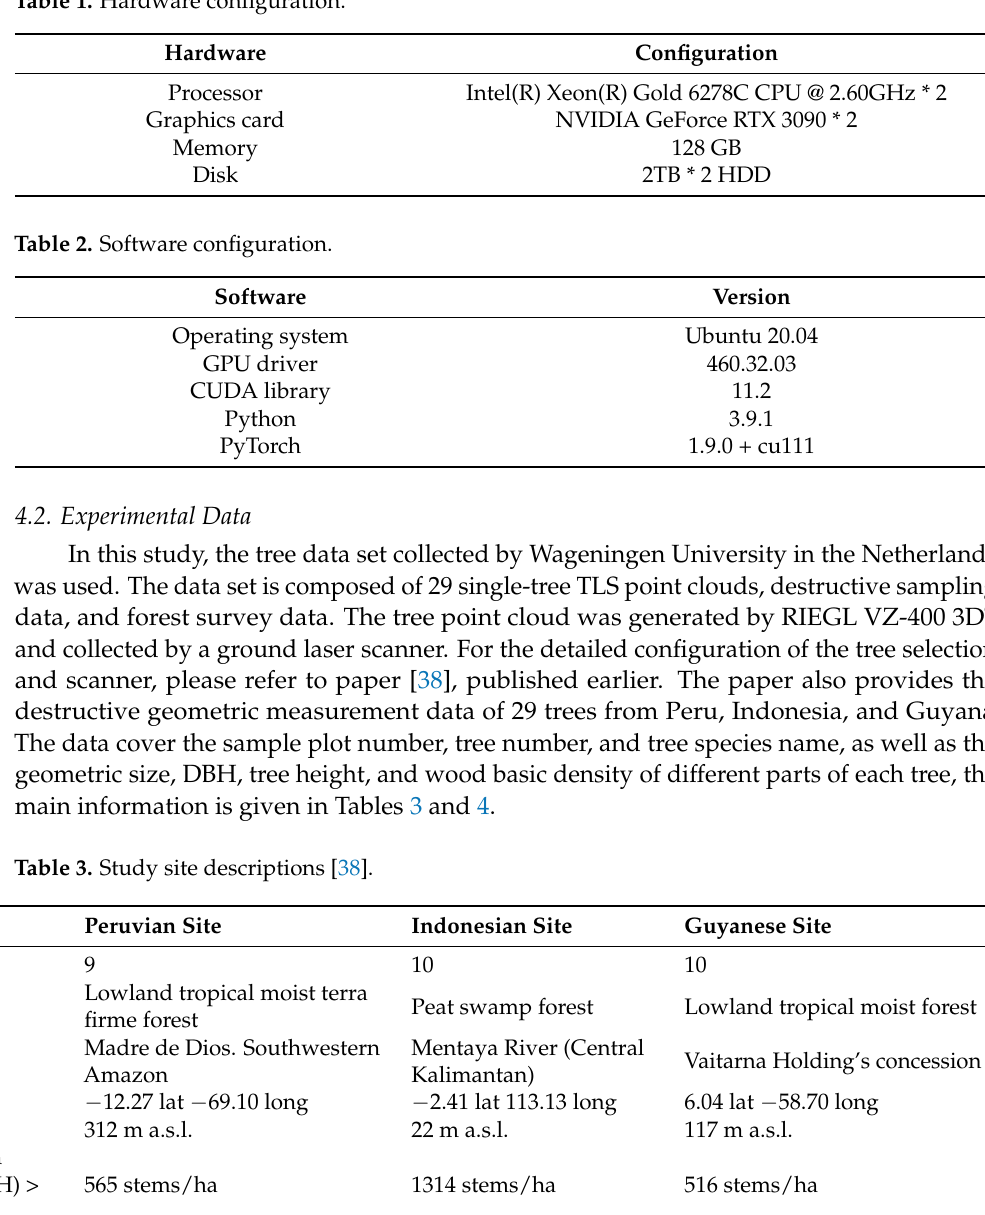
Table 1. Hardware configuration.